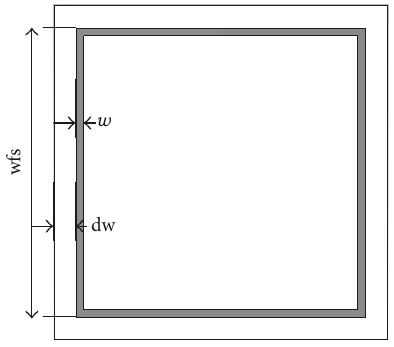
Figure 1: The structure of the unit of the square ring FSS. Figure 2: 𝑆11 of the square ring FSS under the periodic boundary condition.